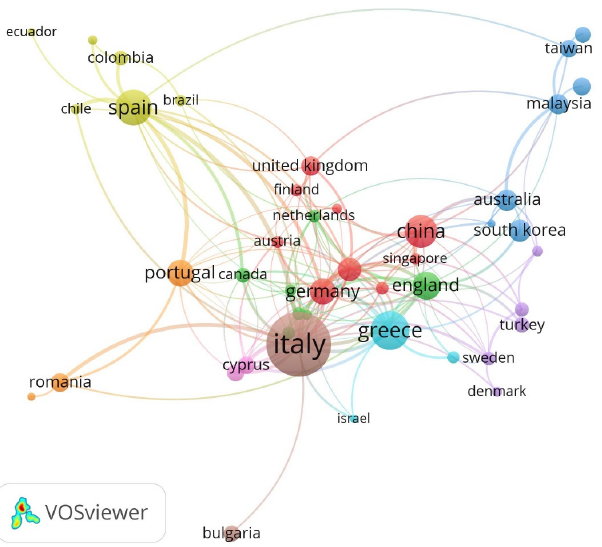
Figure 4. The 10 most active countries in the field of AR in cultural heritage.